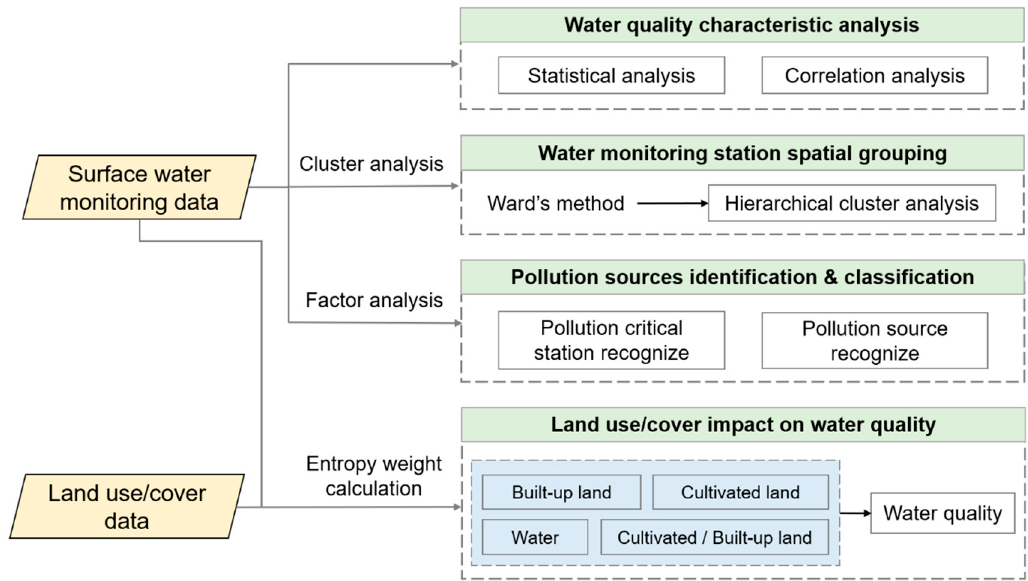
Figure 2. Study flowchart.